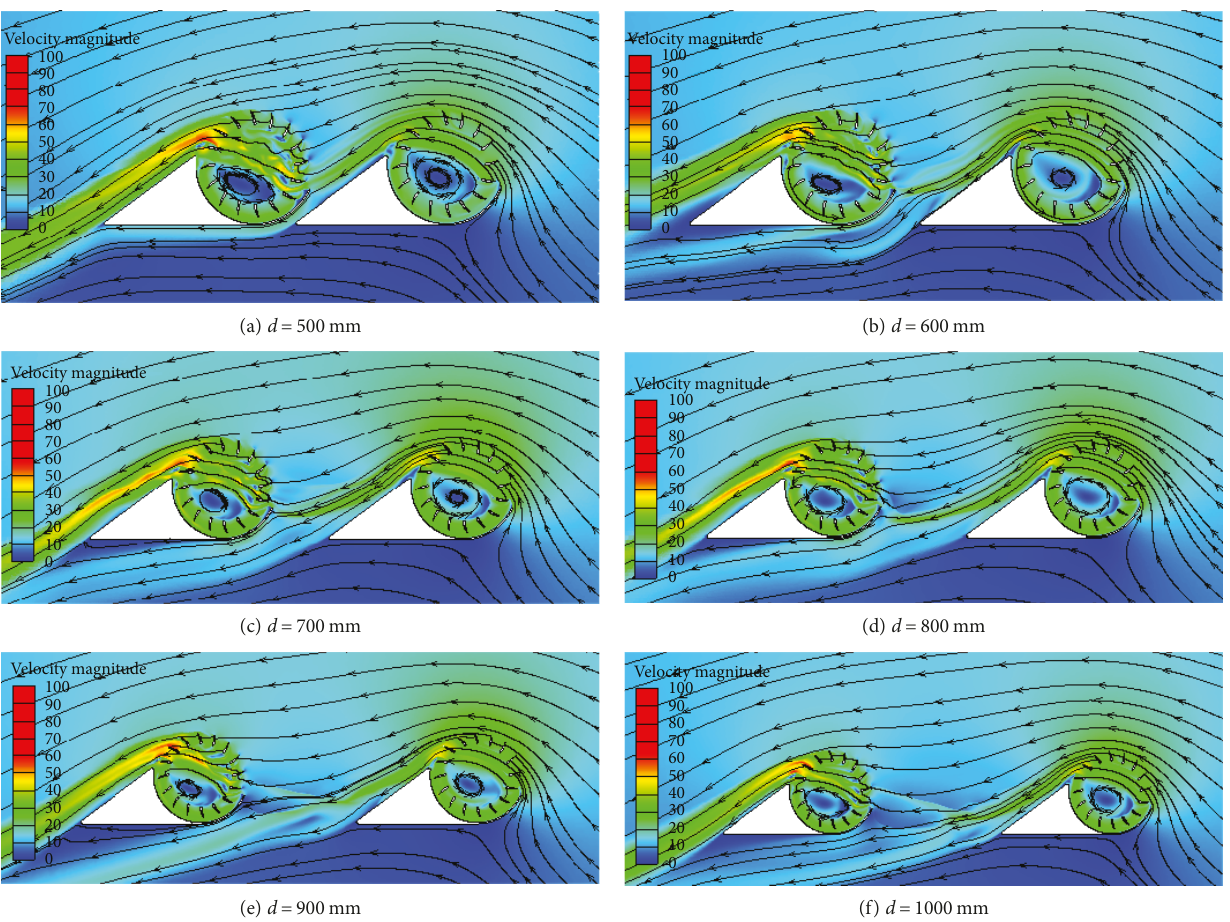
Figure 7: Velocity contours and streamlines of the distance change between the front and rear wings of the tandem fan